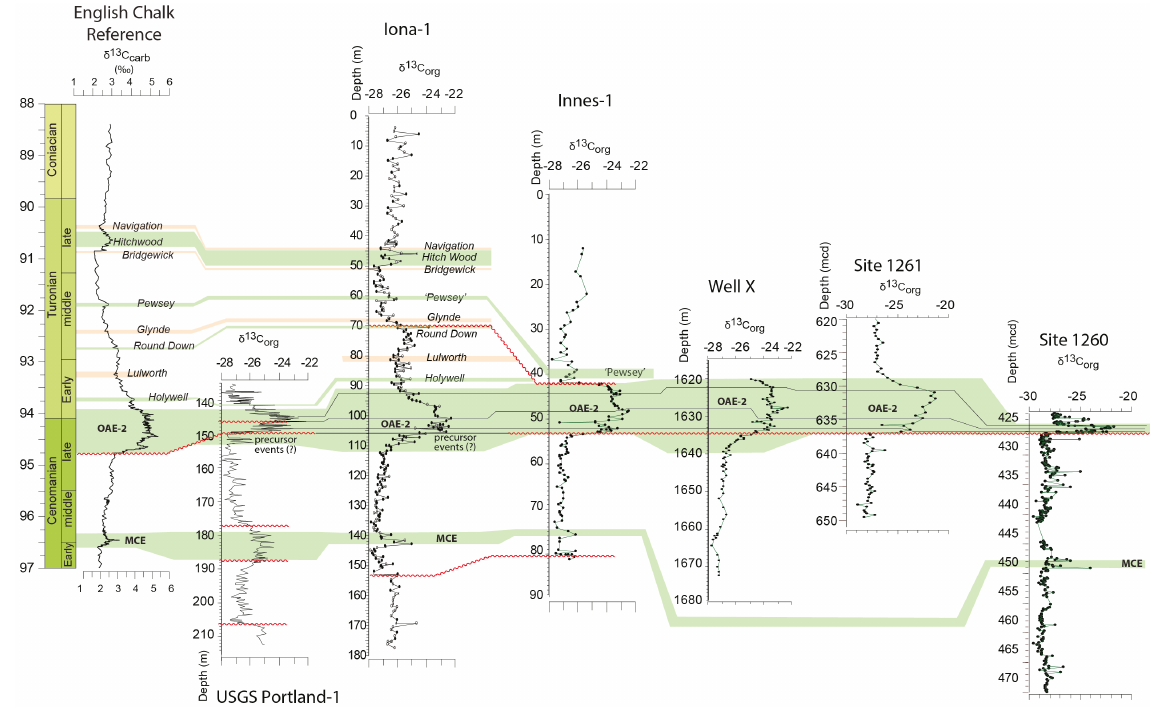
Figure 3. Isotope data and correlation between studied sites and the English Chalk Reference section. Data sources: δ 13 C for English Chalk (Jarvis et al., 2006), USGS Portland-1 (Joo and Sageman, 2014; Eldrett et al., 2014; Duvivier et al., 2014; Eldrett et al., 2015a, this study) ODP sites 1260-1261 (Erbacher et al., 2005; Friedrich et al., 2008) Note variable depth scales. Wavy horizontal red lines represent hiatal surfaces. Green shading, positive δ 13 C isotope events; orange shading, negative δ 13 C isotope events. Isotopic events nomenclature follows that of Jarvis et al. (2006), with the exception of precursor events (after Eldrett et al., 2014), which are now thought to occur within the OAE-2 CIE but in the section not recorded at Portland-1 core or the Pueblo GSSP due to the hiatal surface at the base of the Bridge Creek